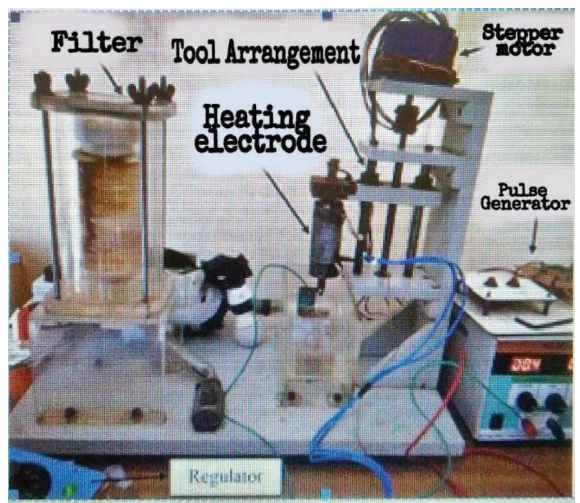
Figure 1: Modifed EMM setup used for experimentation.